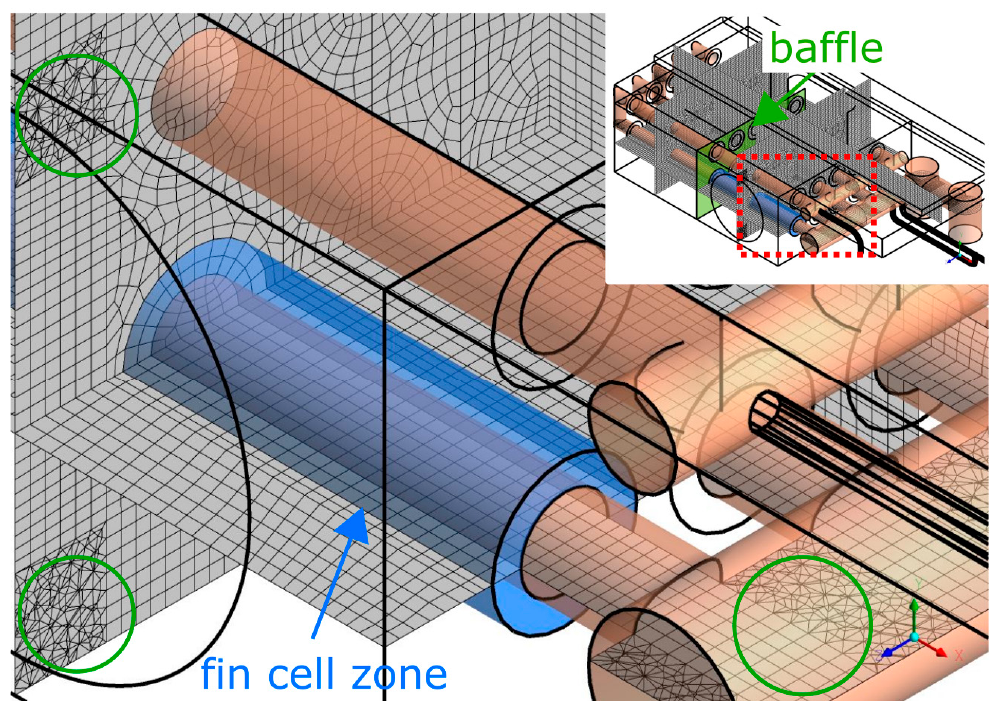
Figure 5. Fragment of the numerical mesh. View on the headers, pipe, and fin cell